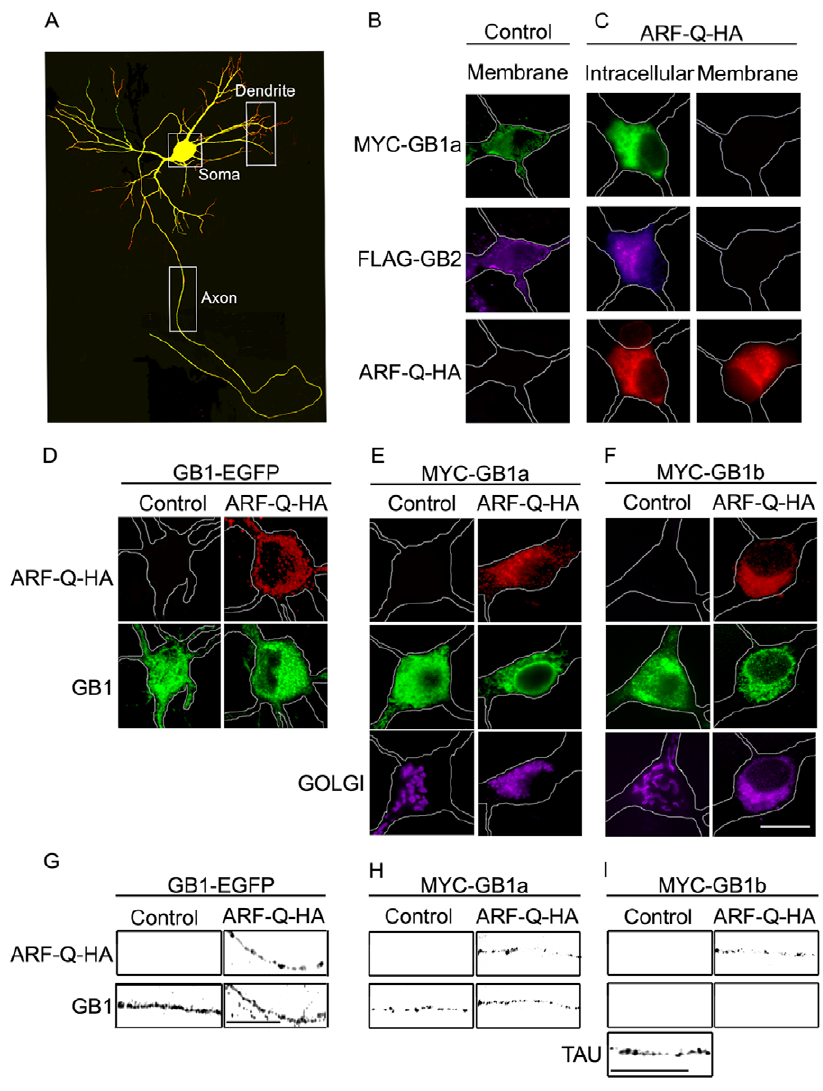
Figure 1. GABA B R1a is targeted to the axon even after blockade of Golgi export. ( A ) Hippocampal neurons were transfected with MYC- GABA B R1a and RFP, and processed for immunofluorescence under permeabilized conditions. MYC-GABA B R1a was detected with MYC antibodies (green) and RFP was detected without staining (red). Boxes indicate somatic, dendritic and axonal regions used throughout the study. ( B ) Hippocampal neurons were transfected with MYC-GABA B R1a and FLAG-GABA B R2 and processed for immunofluorescence under non-permeabilized conditions. MYC-GABA B R1a was detected with MYC antibodies (MYC-GB1a, green) and FLAG-GABA B R2 was detected with FLAG antibodies (FLAG- GB2, magenta) (representative image of n=12 neurons). ( C ) Same as above for neurons transfected with MYC-GABA B R1a, FLAG-GABA B R2, and ARF1- Q71I-HA (ARF-Q-HA). ARF1-Q71I-HA was detected with HA antibodies (red). Neurons were labeled under permeabilized conditions to visualize intracellular GABA B R subunits or non-permeabilized conditions to evaluate their abundance at the plasma membrane (representative image of n=28 neurons). ( D ) Hippocampal neurons from GABA B R1-EGFP mice in the absence (control) or presence of ARF1-Q71I-HA (ARF-Q-HA) and processed for immunofluorescence under permeabilized conditions. ARF1-Q71I-HA was detected with HA antibodies (ARF-Q-HA, red), GABA B R1-EGFP signal was amplified with EGFP antibodies (GB1, green) (representative image of n=10 neurons). ( E ) Hippocampal neurons were transfected with MYC- GABA B R1a in the absence (control) or presence of ARF1-Q71I-HA (ARF-Q-HA) and processed for immunofluorescence under permeabilized conditions. ARF-Q-HA was detected with HA antibodies (red), MYC-GABA B R1a was detected with MYC antibodies (green), the Golgi apparatus was detected by expressing pEYFP-Golgi (magenta) (representative image of n=18 neurons). F ) Same as above for neurons transfected with MYC- GABA B R1b (representative image of n=10 neurons). Scale bar for B-F represents 20 m m. G–I ) Axons of hippocampal neurons under the experimental conditions of D-F (representative images of neurons examined above). Tau staining was used to visualize the axon when not labeled by MYC- GABA B R1b. Scale bar for G–I represents 20 m m. Biermann et. al ., 2010 and modified [8]. Briefly, one-pixel-wide Kif5C-RFP-DN transfected neurons. Average pixel intensities of MYC-GABA B R1a were determined along the traced lines, lines were traced along the initial 150 m m of axons and dendrites background was subtracted and the data was used to determine in images labeled with soluble RFP or Kif5C-RFP-DN. No the A:D ratio. Criteria for cell selection included even distribution measurements were carried out beyond 150 m m to prevent of RFP or Kif5C-RFP-DN in axons and dendrites, and cells artifacts due to axonal length differences between RFP or